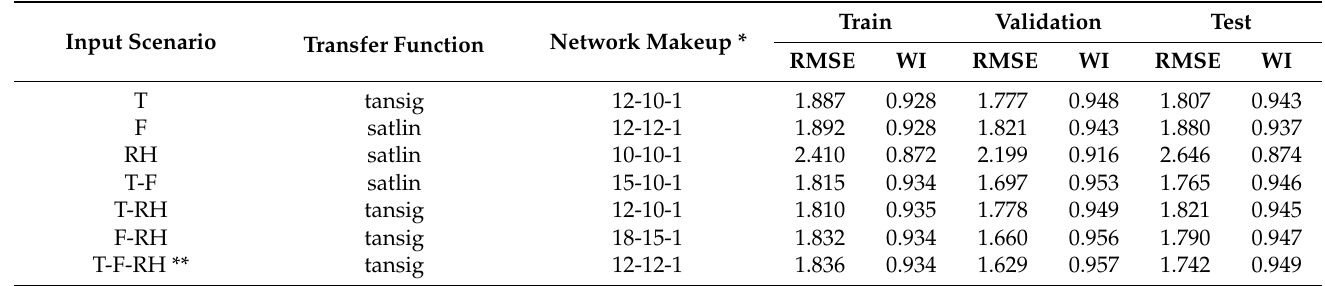
Table 4. Evaluation metrics for the pan evaporation modeling of MLP, learned by Bayesian regular- ization algorithm (MLP-BR).